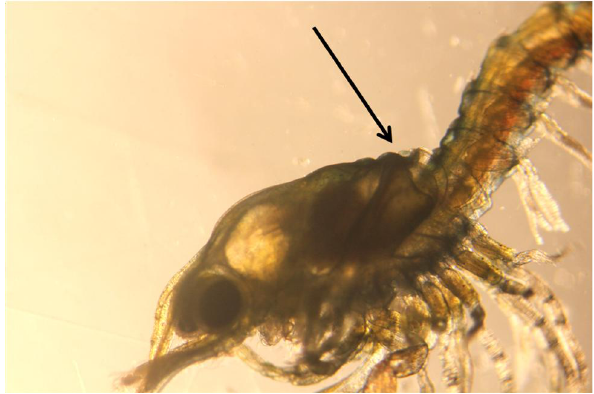
Figure 6. Fig. 6. A stage 3 Homarus gammarus larvae raised in an environ- ment with pH lower than 7.9. The carapace is curled, leaving “curls” on the side (indicated with the arrow). This is classified as a defor-